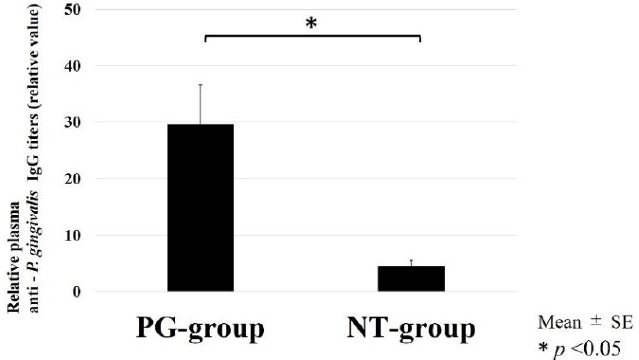
Figure 2. Serum IgG antibody titers in response to P. gingivalis